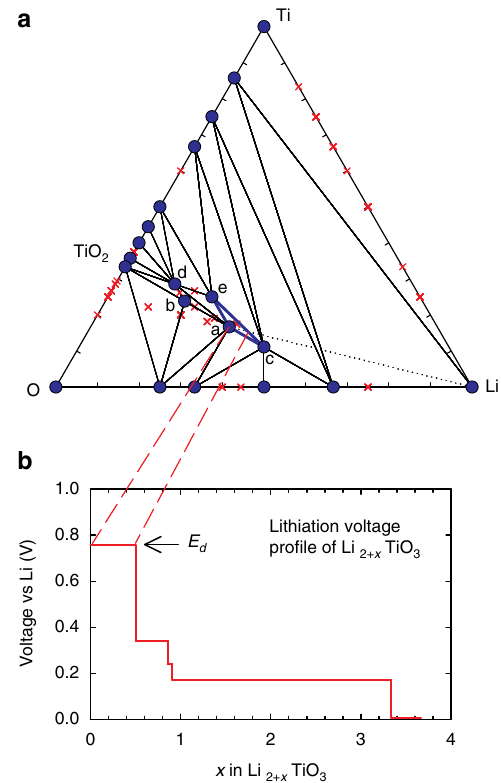
Figure 2 | Stability and lithiation of Li 2 TiO 3 coating. ( a ) Ternary Li–Ti–O phase diagram obtained from the OQMD, where the stable and unstable phases are shown as circles and crosses, respectively. Compounds marked as a,b,c,d,e correspond to Li 2 TiO 3 , Li 4 Ti 5 O 12 , Li 4 TiO 4 , LiTi 2 O 4 and LiTiO 2 , respectively. The O 2 chemical potential corresponds to T ¼ 298K and P ¼ 1 atm. Dotted-line shows the lithiation path of Li 2 TiO 3 , and the first phase region along this path is highlighted with bold tie-lines. The corresponding voltage profile of Li 2 þ x TiO 3 as a function of x along this path is given in b , where the arrow points at the highest voltage step; that is, the discharge potential criterion ( E d ) of this coating candidate as we use in the framework.